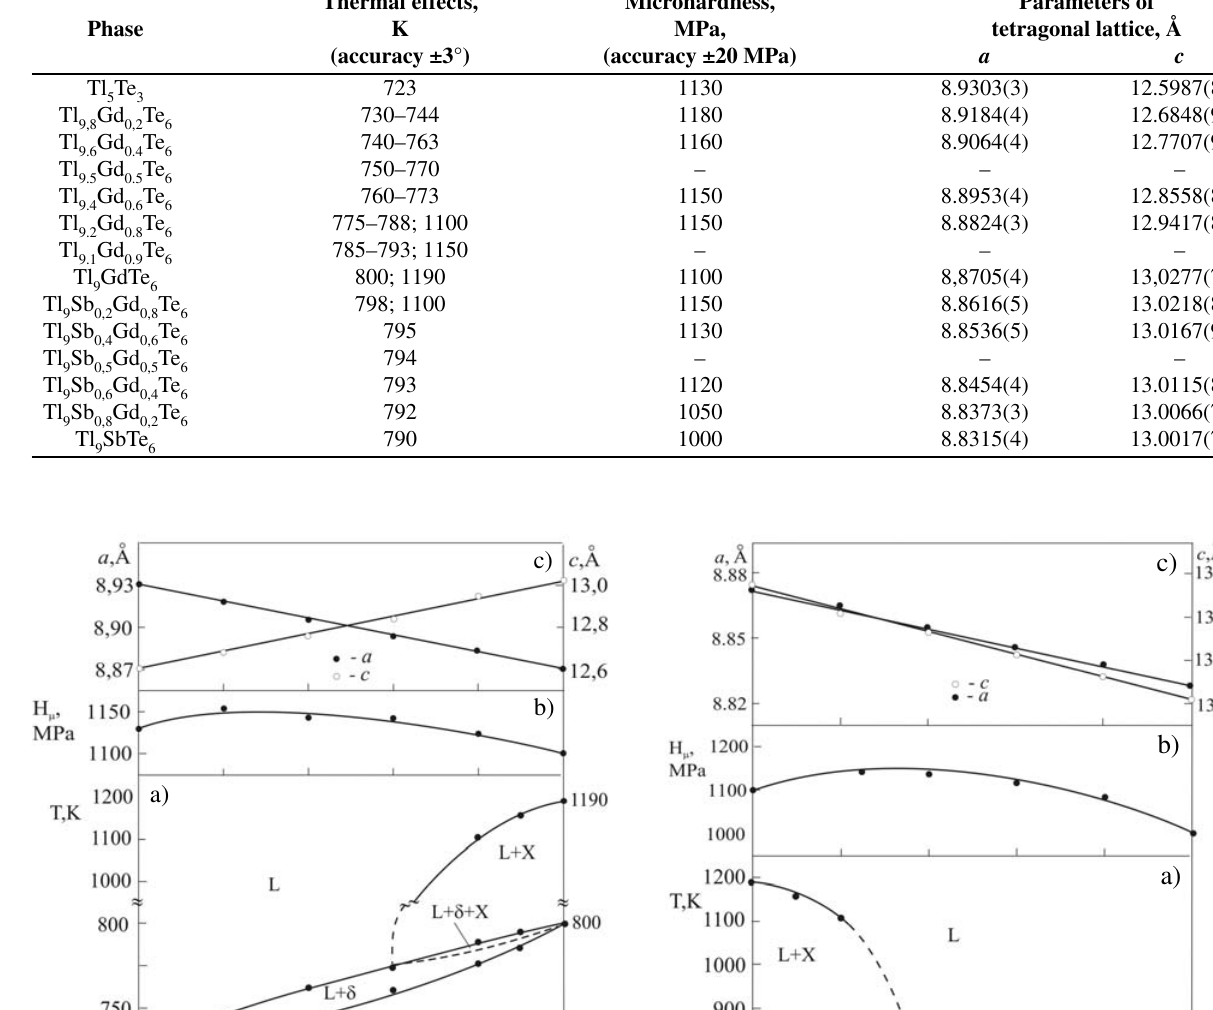
Table 1. Some properties of phases in the Tl